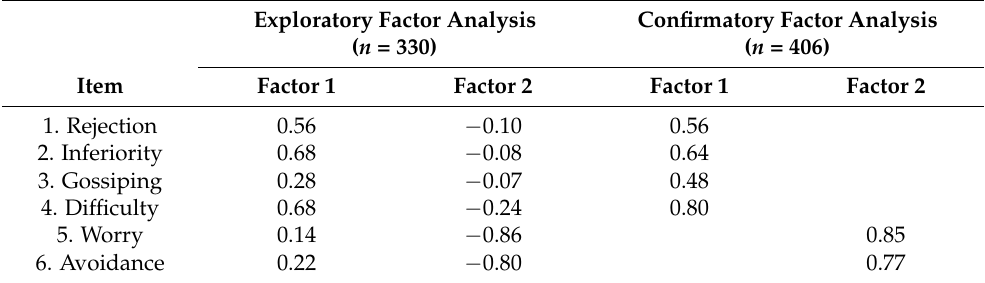
Table 4. Concurrent validity of the Experienced and Anticipated Sexual Stigma Scale in Health-care Services (EASSSiHS).